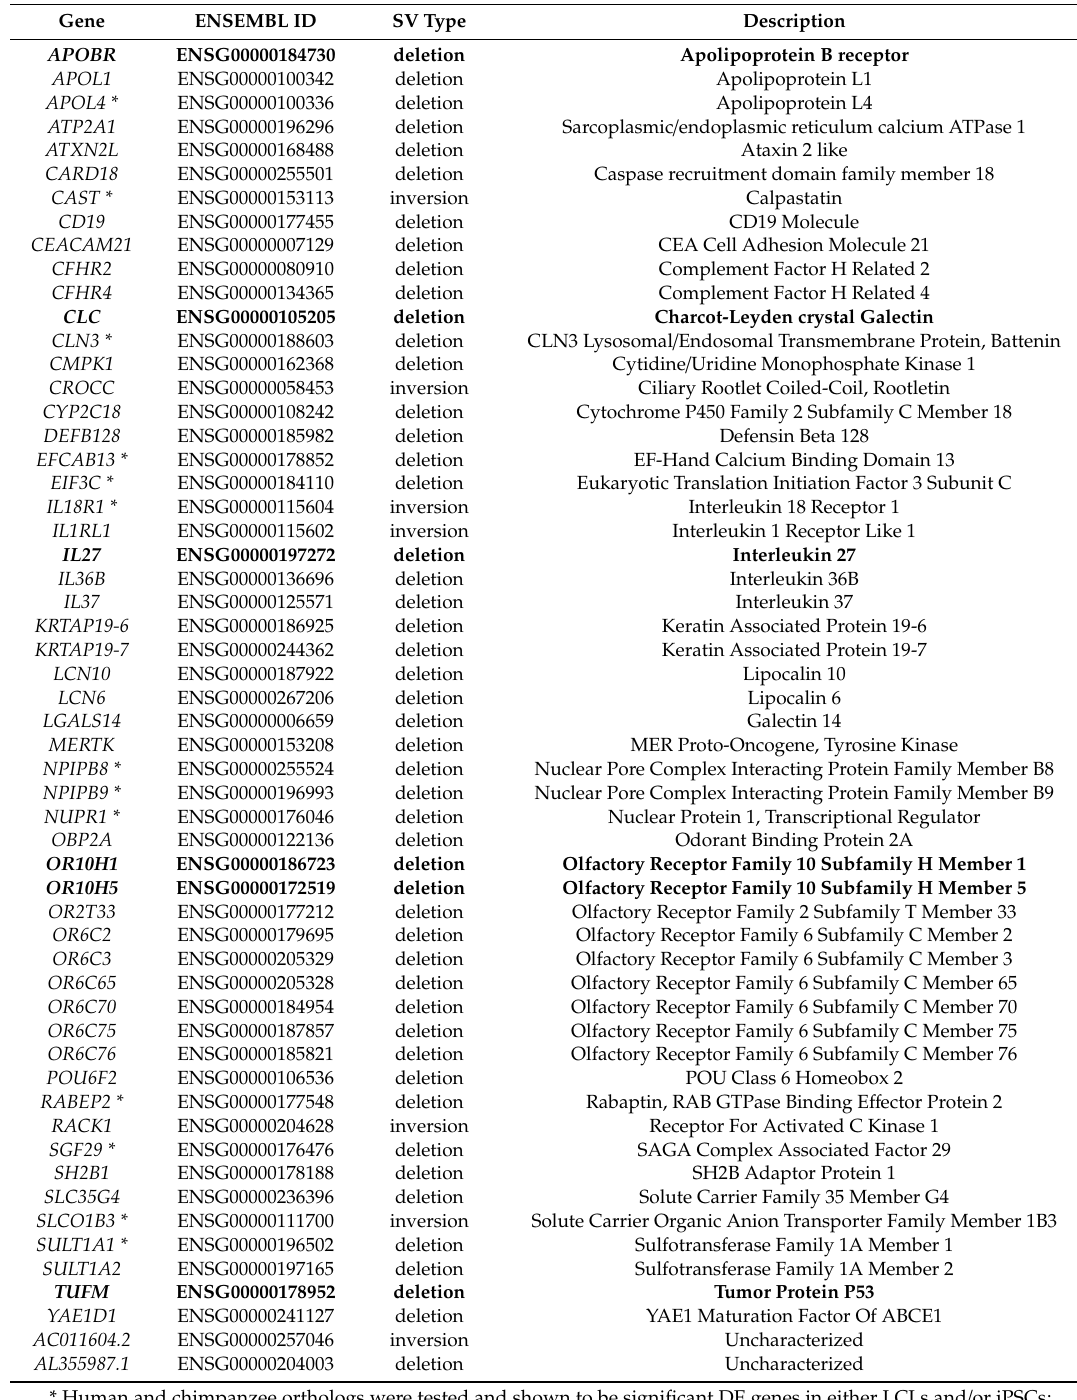
Table 1. Protein-encoding genes impacted by chimpanzee-specific deletions and